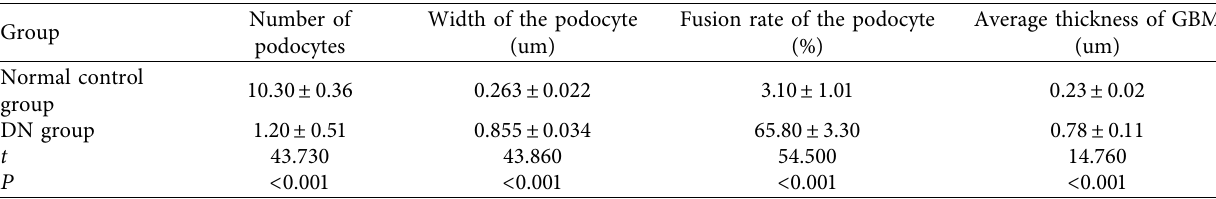
Table 1: Number of podocytes, the podocyte width, the podocyte fusion rate, and the average thickness of the GBM in the control group ( x ± s ).